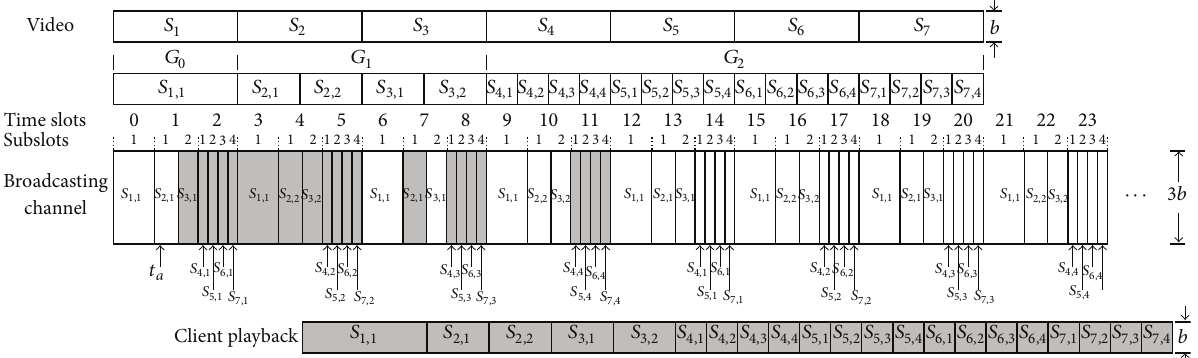
Figure 3: Segment downloading and playing for the proposed scheme.